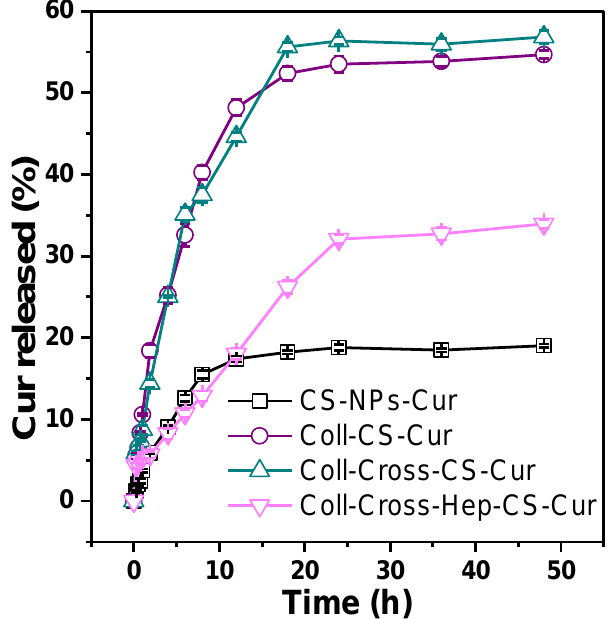
Figure 8. Cumulative Cur release from NPs and collagen patches.